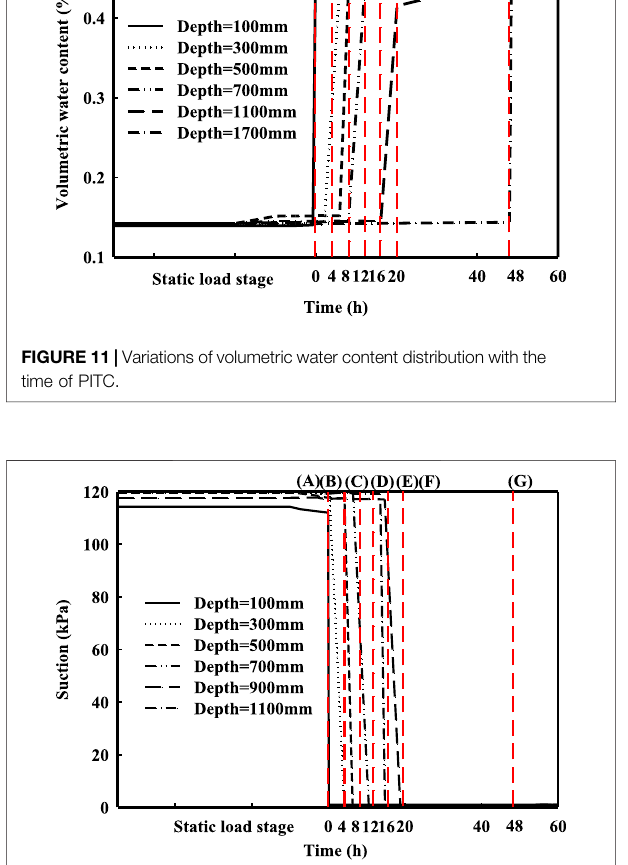
FIGURE 12 | Variations of water potential (suction) distribution with the time of PITC.